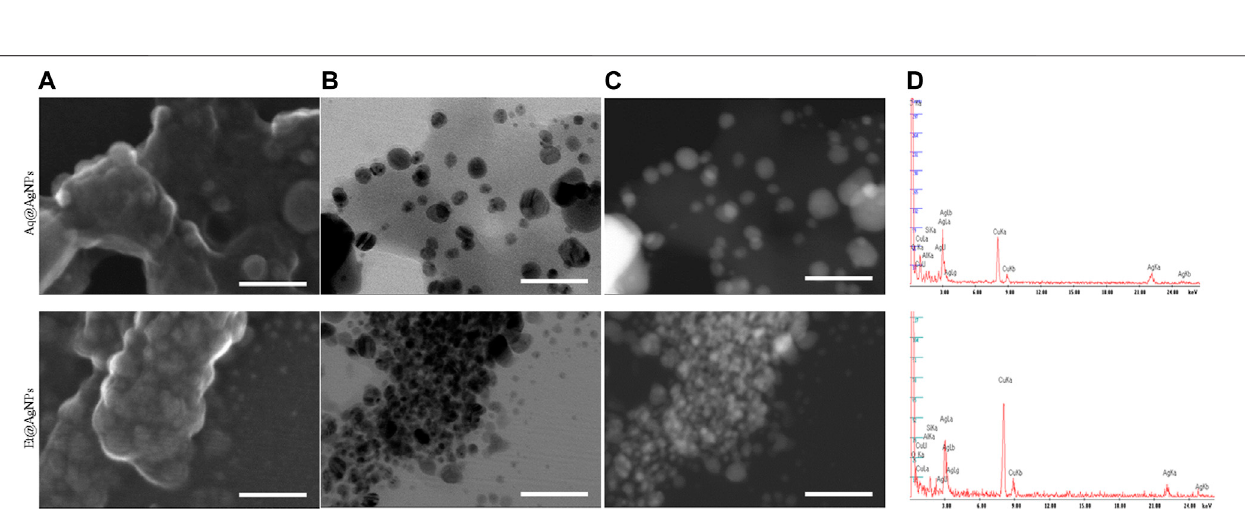
FIGURE3| AnalysisoftheshapeandmorphologyofbiogenicAq@AgNPsusingscanningTEM. (A) SEimagesindicatedbiogenicpolymerscomposingthesurface of NPs. (B) Scanning TEM and (C) HAADF images (Z-contrast images) revealed the presence of bAgNPs coated with polymers (x500 k). (D) Peaks in 2 – 4 keV in EDX analysis con fi rmed that the constituent element included Ag. Scale bar: 60